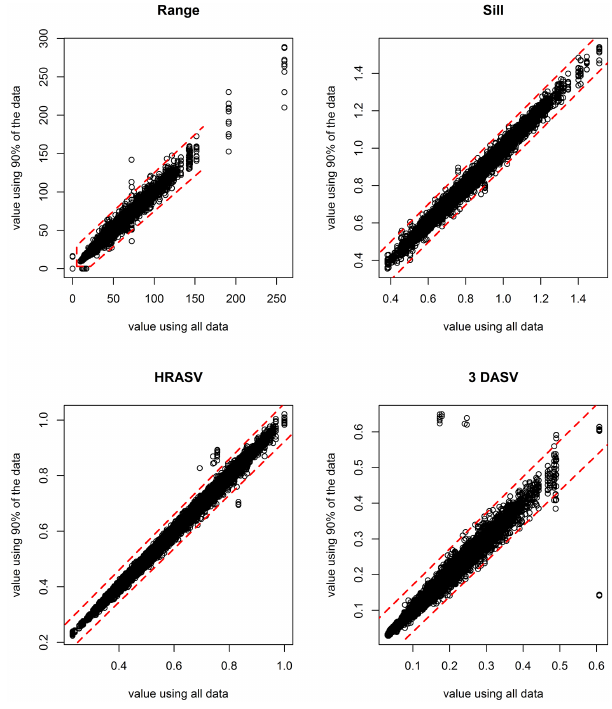
Figure 4. Changes in the variogram parameters resulting from the artificial changes to the time series for the South Tyne; the upper and lower threshols are the fifth and ninth percentiles calculated from the 1000 realisations of the variogram.